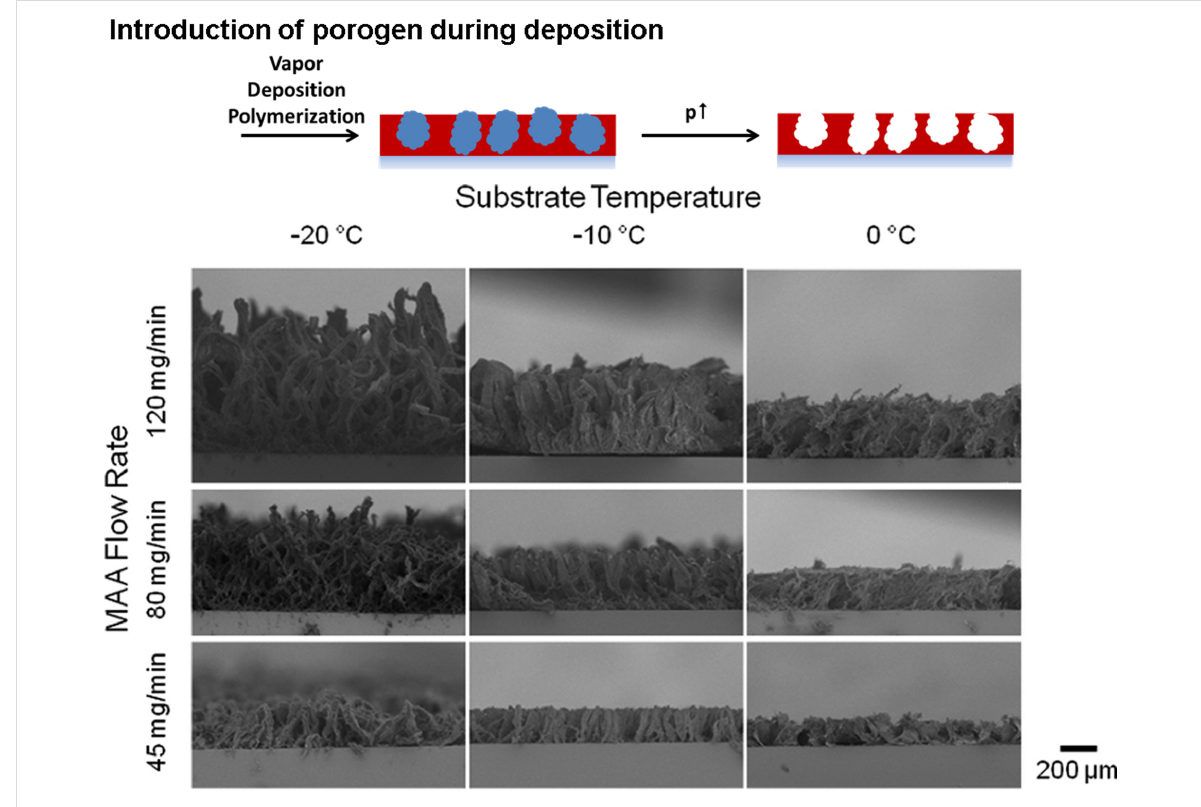
Figure 4: Polymer structures created via introduction of a porogen during the deposition process: the images show the extent of the deposition of solid monomer, which occurs simultaneously with polymerization. Thereby, the resulting morphology can be varied by the monomer flow rates or the substrate temperature. Reprinted with permission from [33], copyright 2014 American Vacuum